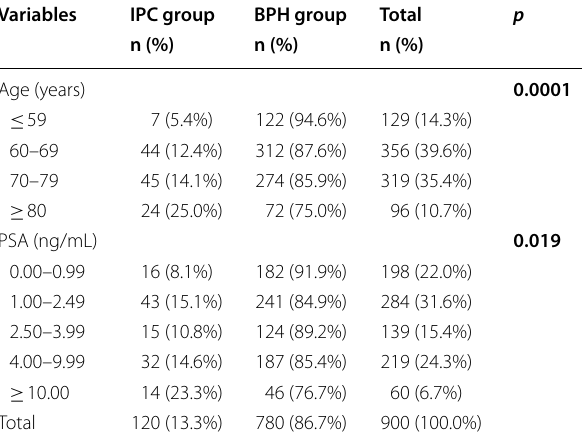
Table 2 Comparison of age and PSA levels in the incidental prostate cancer and benign prostatic hyperplasia groups